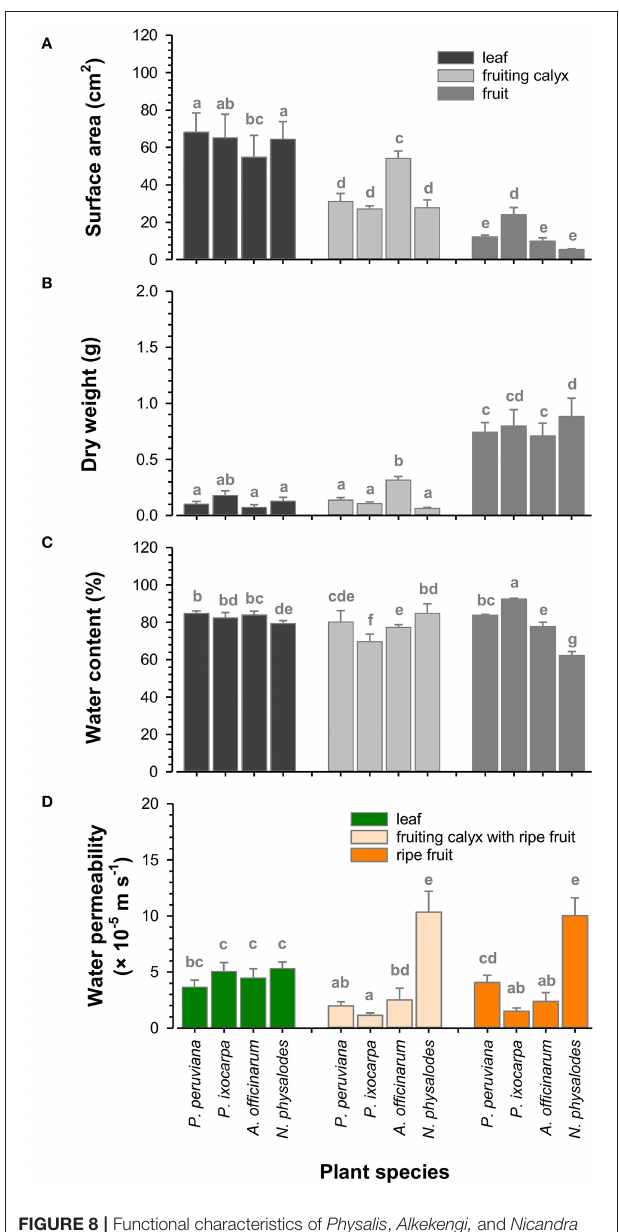
FIGURE 8 | Functional characteristics of Physalis , Alkekengi, and Nicandra species . Total surface area (A) , dry weight (B) , and relative water content (C) of fully expanded leaves, fully inflated fruiting calyces, and ripe fruits were measured. Minimum water conductance was investigated for leaves and fruiting calyces, including fruits. Cuticular water permeability was investigated for fruits without fruiting calyces (D) . Data are shown as mean ± SD ( n ≥ 8). Different letters indicate significant differences ( p <